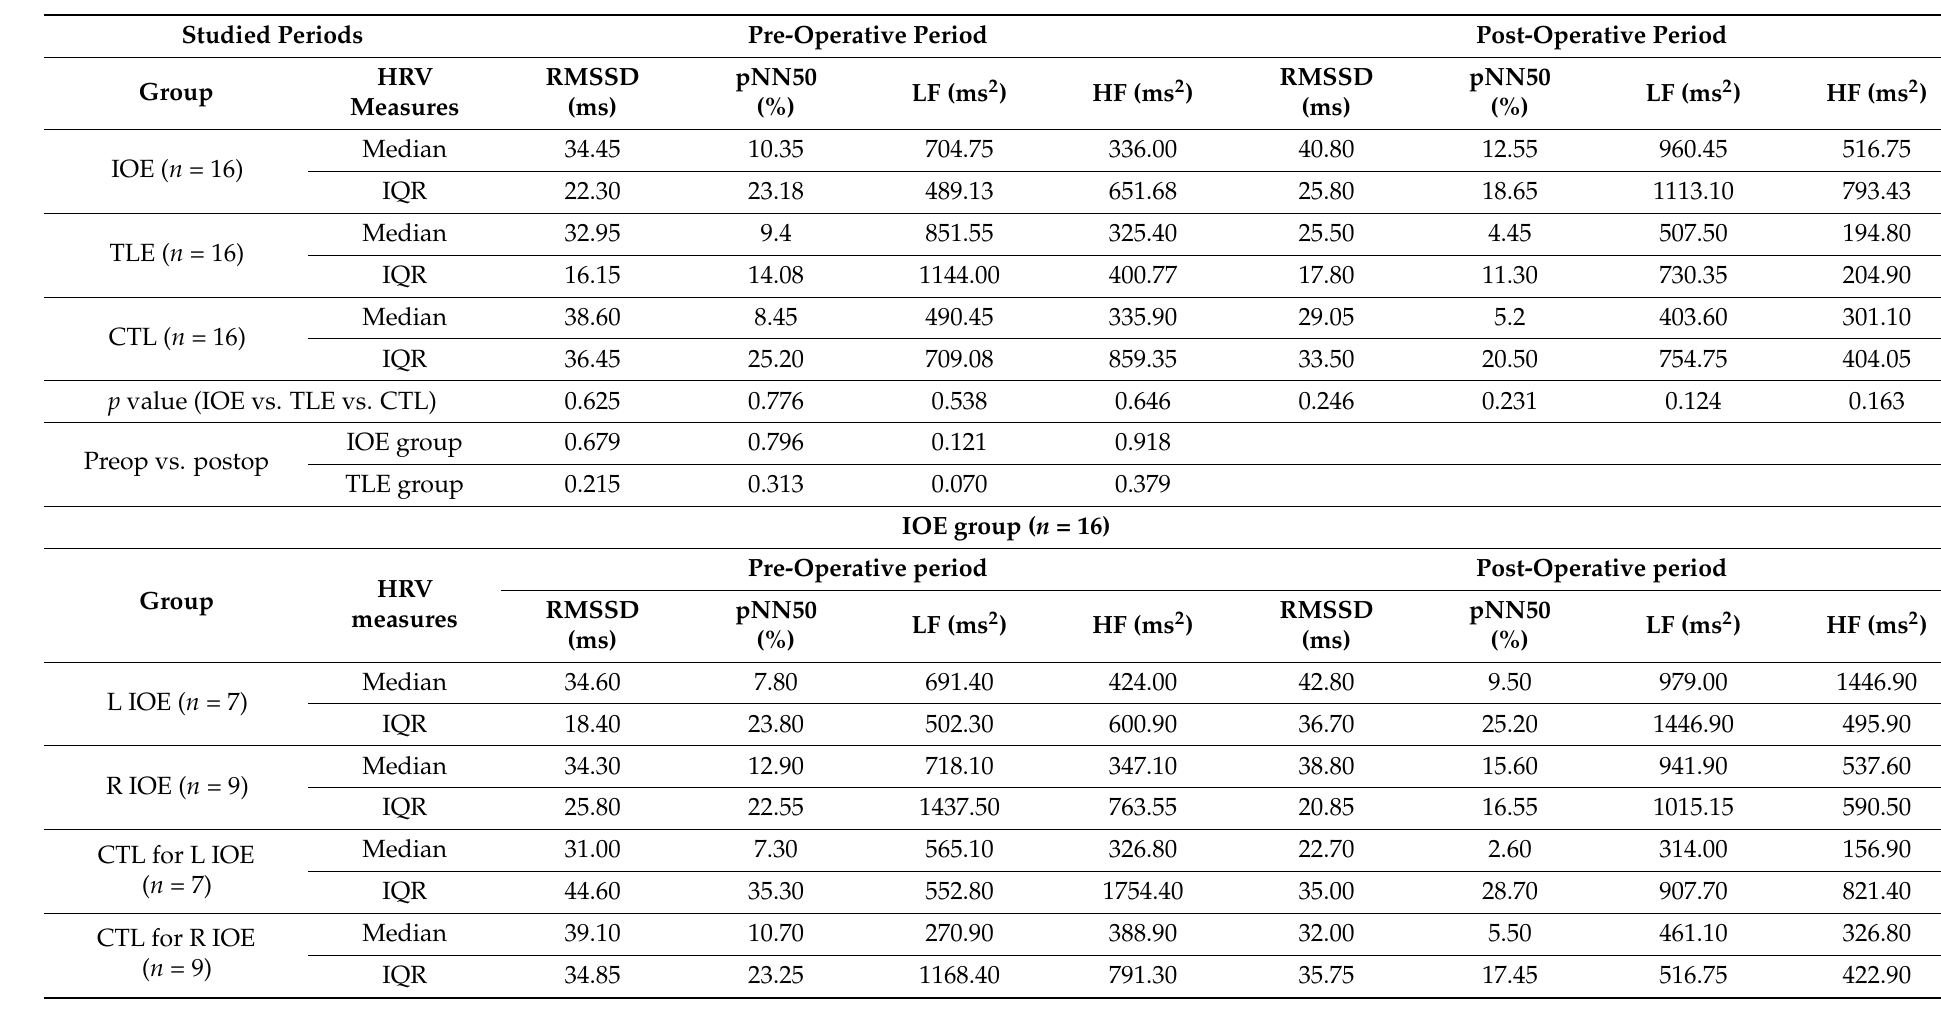
Table 4. Pre- and post-operative HRV values for IOE, TLE and healthy control